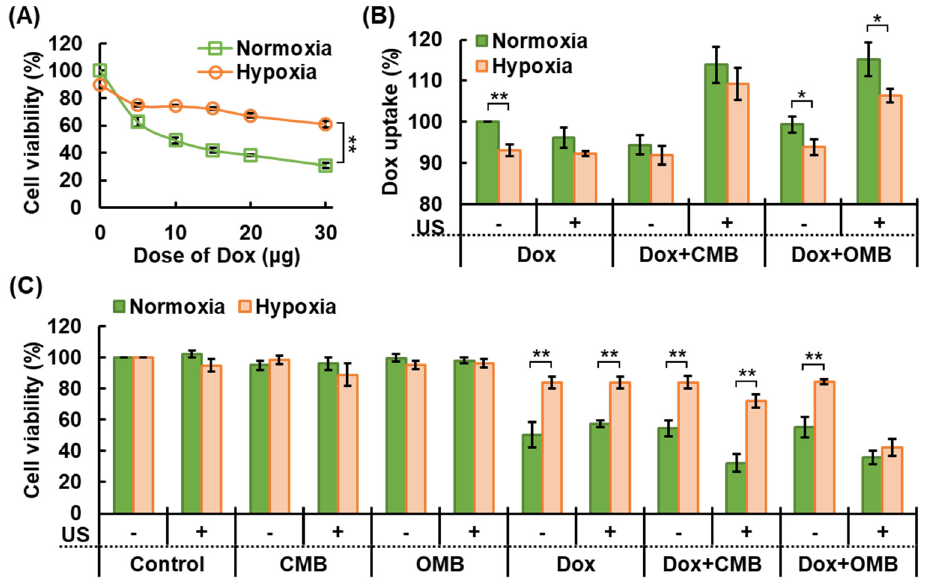
Figure 7. Overcoming HDR by OMB treatment. ( A ) Cell viability after Dox treatment shows the HDR effect in hypoxic tumor cells (** p < 0.01). ( B ) Intracellular Dox uptake was promoted by enhanced cell membrane permeability induced by MB cavitation (* p < 0.05, ** p < 0.01). ( C ) Evaluation of cell viability demonstrated that the combination of Dox and OMB treatment enhanced cytotoxicity and overcame the HDR (** p < 0.01).